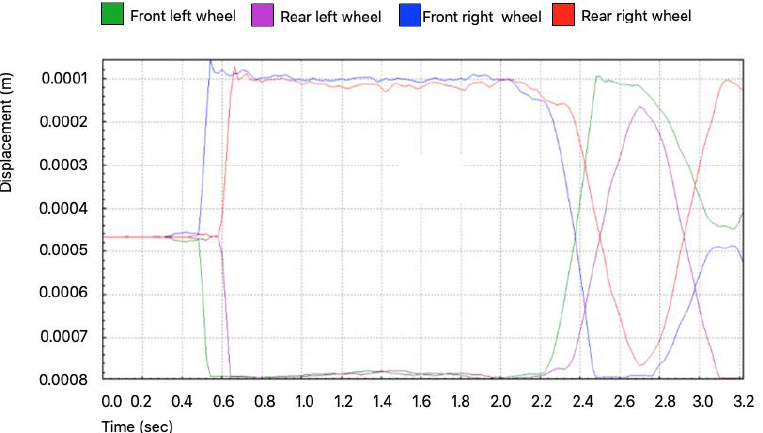
Figure 10. Position of the centres of mass of the wheels as the car undergoes conventional deflection.